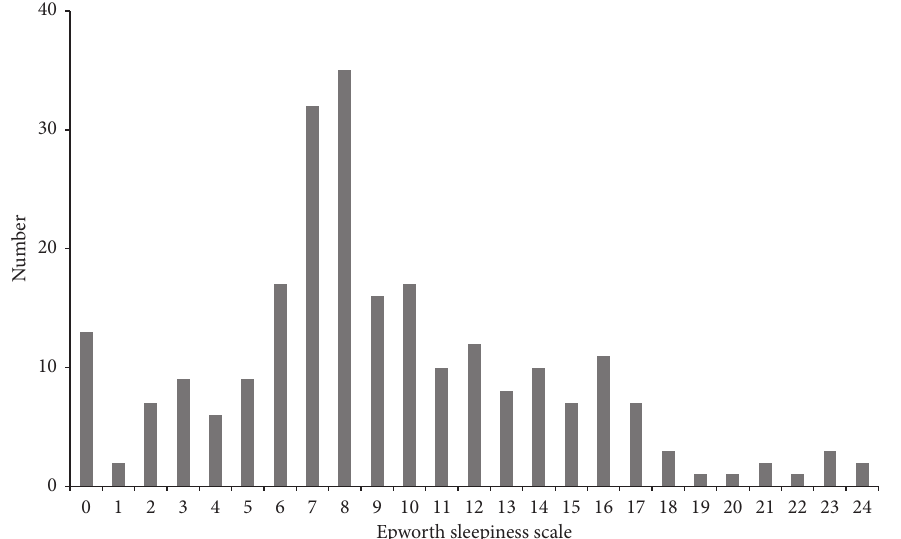
Figure 2: Distribution of the Epworth sleepiness scale scores among the emergency medicine